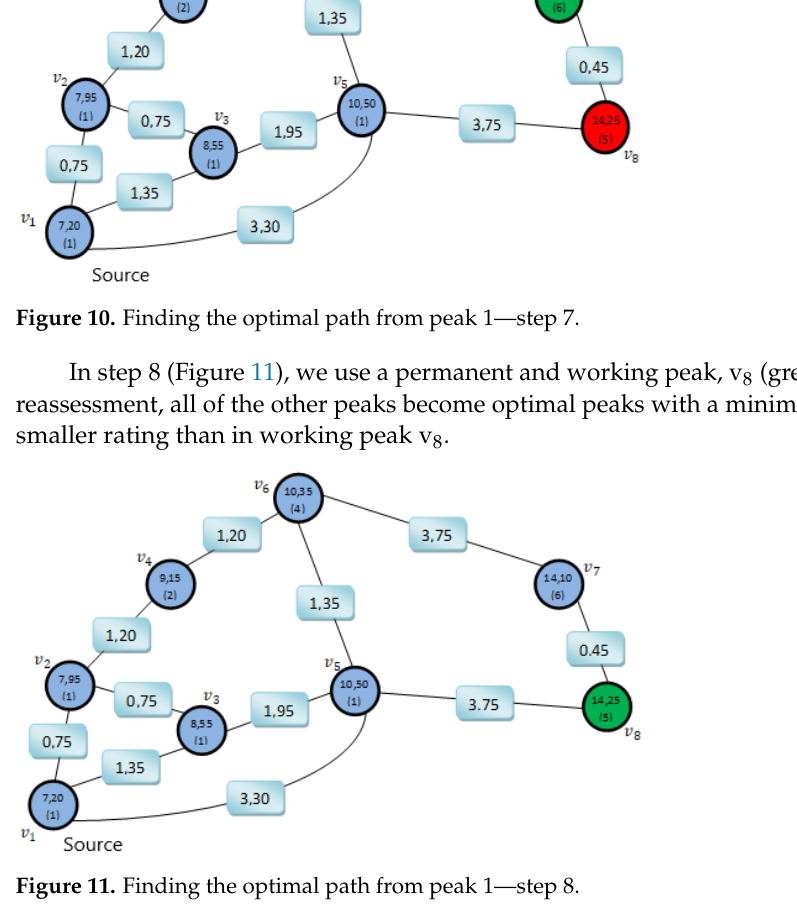
Figure 12. Finding the optimal path from peak 1—finalization. To illustrate the creation of a model for finding the optimal path based on the data obtained using our algorithm, which we worked with to find the most financially advan- tageous connection along the path from the customer to the supplier location, we use the following graph showing the optimal route (Figure 13):